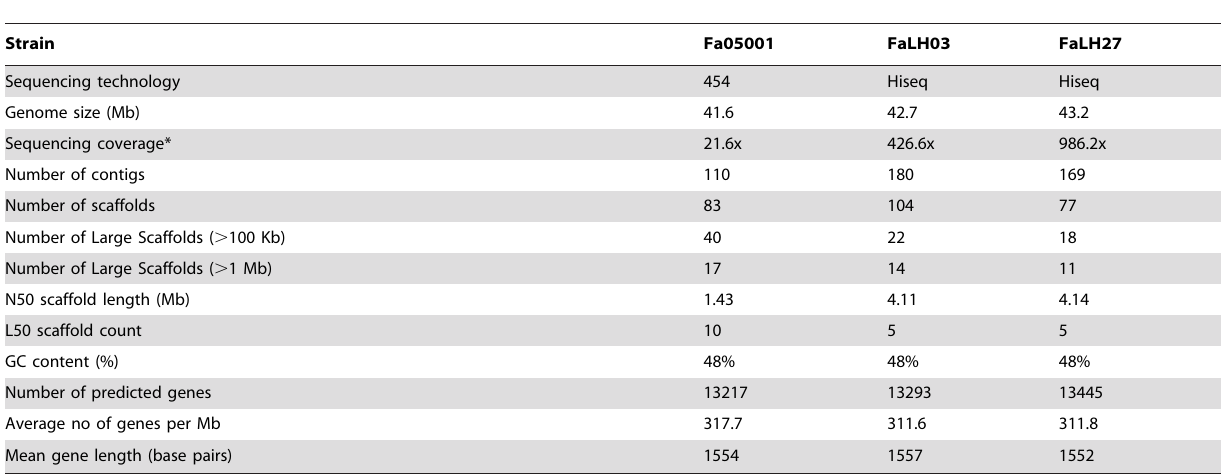
Table 1. Main assembly summary and annotation features of the three F. avenaceum